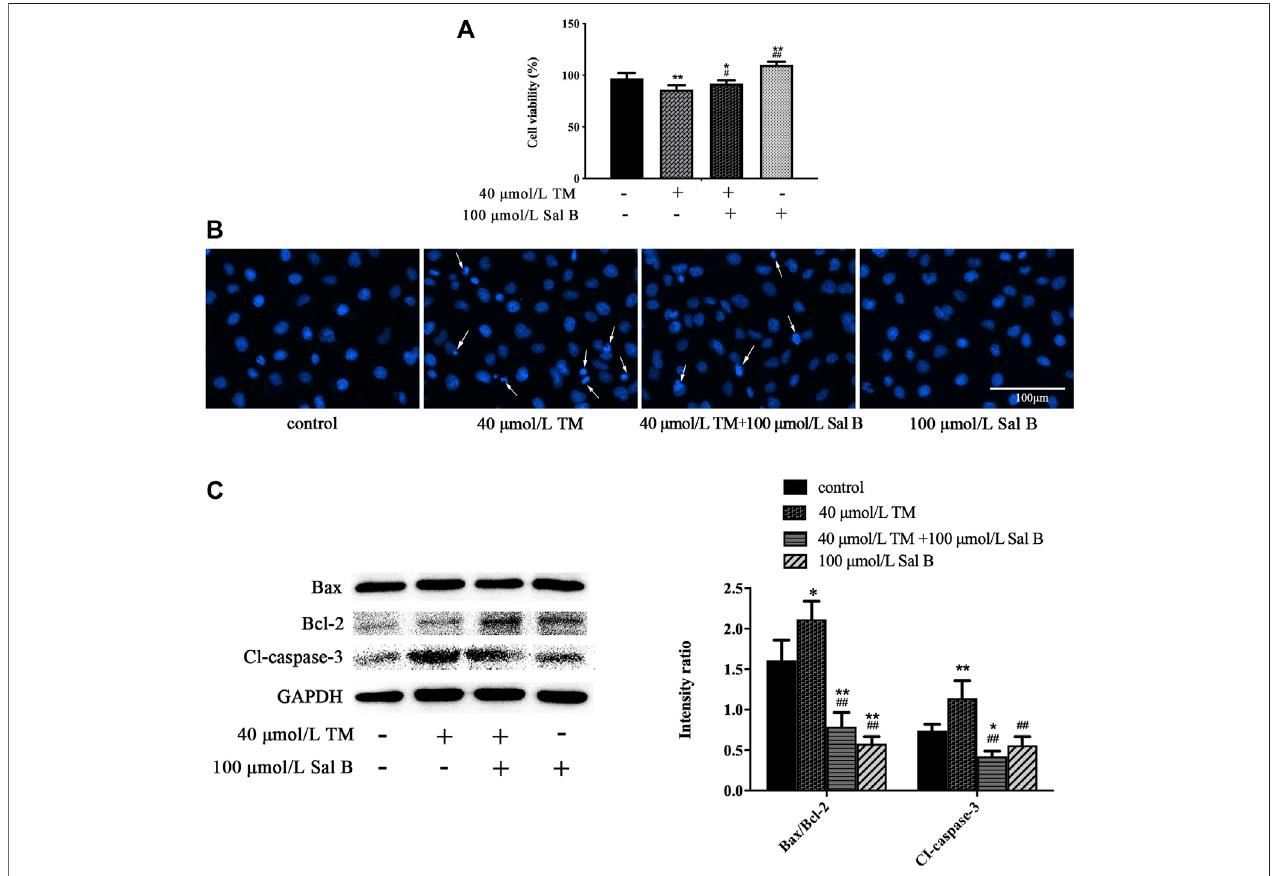
FIGURE 7 | Sal B counteracted TM-induced apoptosis. (A) Sal B alleviated the decrease in cell viability caused by TM. The data were determined by ANOVA and LSD post-hoc test and are presented as the mean ± SD (n (cid:1) 5). * P < 0.05, ** P < 0.01 vs. control group; # P < 0.05, ## P < 0.01 vs. TM group. (B) Sal B attenuated TM- induced apoptosis of HK-2 cells. (C) Sal B reduced the ratio of Bax/Bcl-2 and level of cleaved caspase-3. The data were determined by ANOVA and LSD post-hoc test and are presented as the mean ± SD ( n (cid:1) 3). * P < 0.05, ** P < 0.01 vs. control group. # P < 0.05, ## P < 0.01 vs. TM